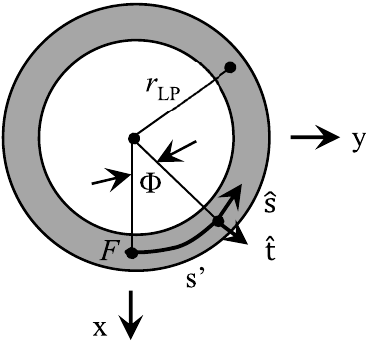
Fig. 12. Round model-N.